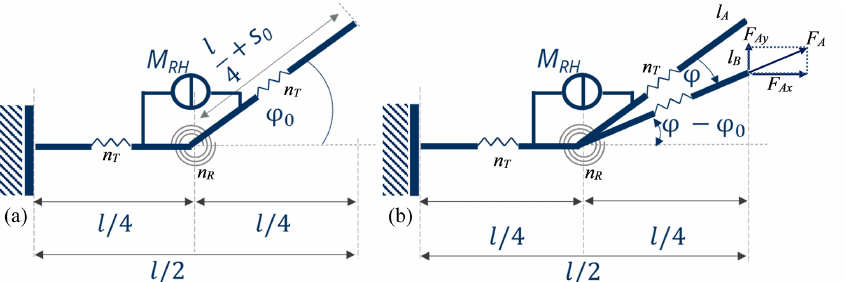
Figure 3. Mechanical model for a pre-deflected bending beam with length l/ 2, pre-deflection angle ϕ 0 , torsional spring n R , translational spring n T and humidity-dependent bending moment M RH (a) without and (b) with axial compressive force F A .